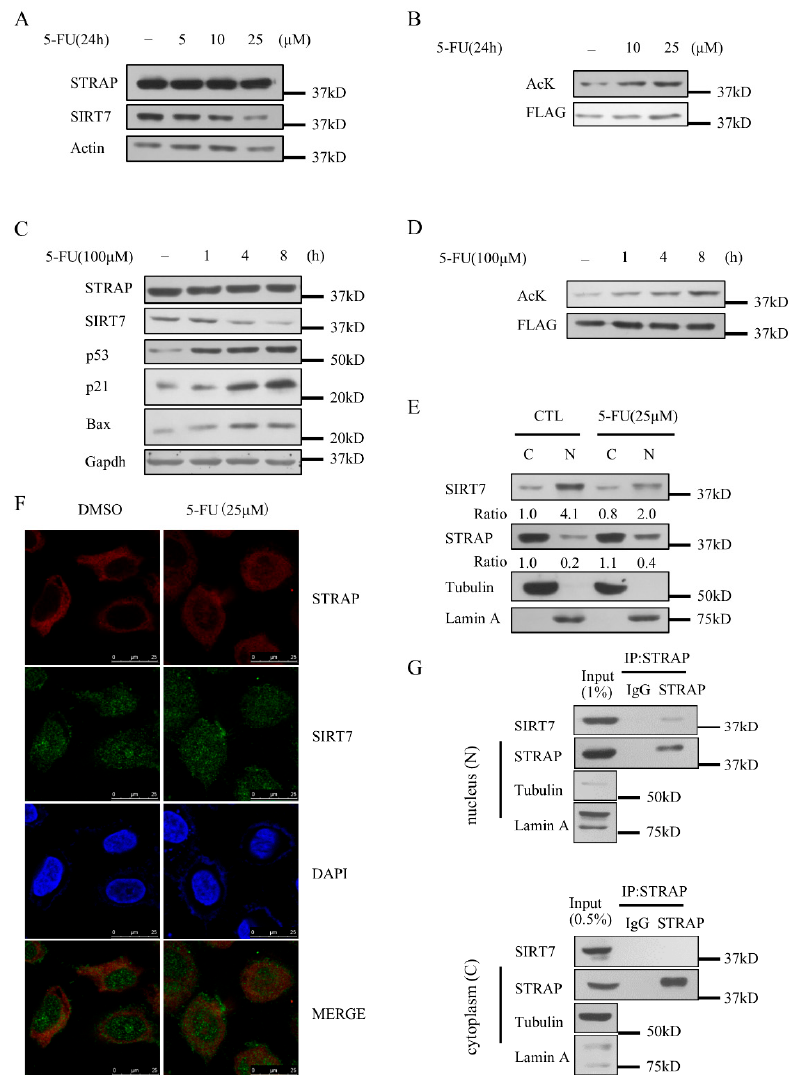
Figure 6. STRAP acetylation levels are specifically modulated by 5-fluorouracil (5-FU). ( A ) Western blotting for STRAP or SIRT7 endogenous levels in HCT116 cells following 5-FU treatment at 5, 10, 25 µ M for 24 h. ( B ) Increases in STRAP acetylation status upon 5-FU treatment. Flag-STRAP was immune-precipitated from HCT116 cells treated with DMSO, 10 µ M, 25 µ M 5-FU for 24 h, and eluted for Western blotting with an anti-pan-acetylation antibody. ( C ) Western blotting for STRAP or SIRT7 endogenous levels in HCT116 cells following 100 µ M 5-FU treatment for 0, 1, 4, and 8 h. ( D ) Increases in STRAP acetylation status upon 5-FU treatment. Flag-STRAP was immune-precipitated from HCT116 cells treated with 100 µ M 5-FU treatment for 0, 1, 4, and 8 h and eluted for Western blotting with an anti-pan-acetylation antibody. ( E ) Subcellular localization of STRAP and SIRT7 treated with or without 5-FU revealed by biochemical fractionation. U2OS cell lysates were analyzed by antibodies as indicated. ( F ) Co-localization of STRAP and SIRT7. U2OS cells were immune-stained using anti-STRAP or anti-SIRT7 antibodies, followed by Alexa Fluor-594 anti-mouse antibody (for STRAP, in red) or Alexa Fluor-488 anti-rabbit antibody (for SIRT7, in green) and then examined using confocal microscopy. Yellow staining in the merged images shows co-localization between STRAP and SIRT7 after 5-FU treatment. Representative images are shown. ( G ) Co-immunoprecipitation (Co-IP) of STRAP with SIRT7 in the nucleus (N) and cytoplasm (C) upon 5-FU treatment. Treated HCT116 cells with 25 µ M 5-FU for 24 h, separated cytoplasm and nucleus by biochemical fractionation, then immune-precipitated with and analyzed by antibodies as